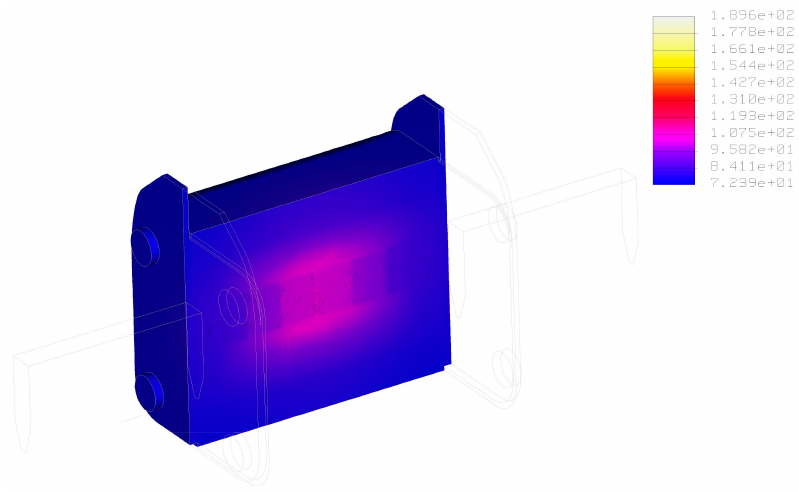
Figure 5. Temperature release through the least loaded fuselink, for 180 A current and asymmetry coefficient of 0.8.